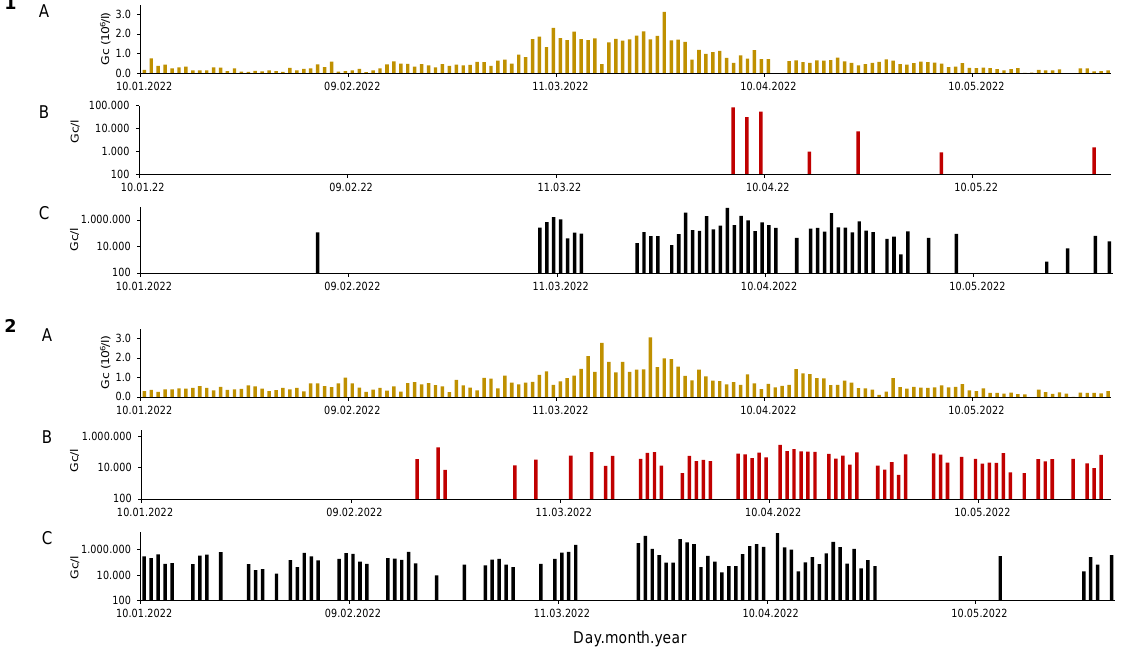
Figure 1. Concentrations of genome copies (gc) of SARS-CoV-2 (E gene; ( A )), influenza virus A ( B ) and B ( C ) in raw wastewater of WWTPs 1 and 2. Bars represent mean gc/L of two technical RT-qPCR amplifications for each